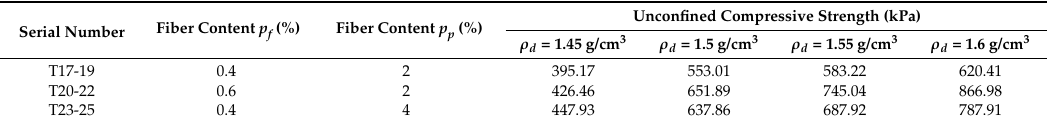
Table 5. Unconfined compressive strength of specimens with different dry densities and 48-h curing time.